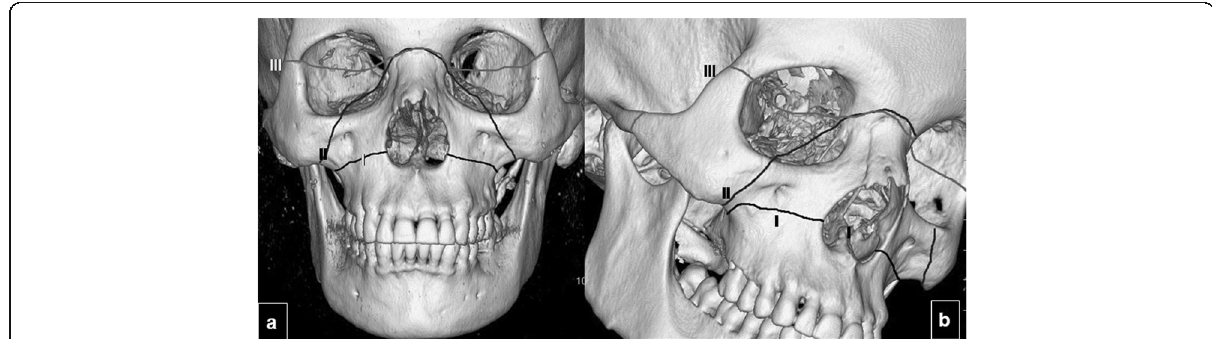
Fig. 7 Le Fort fracture patterns. Three dimensional CT images of an adult skull in frontal ( a ) and oblique ( b ) orientations show the osseous facial structures classically affected in type I, II, and III Le Fort